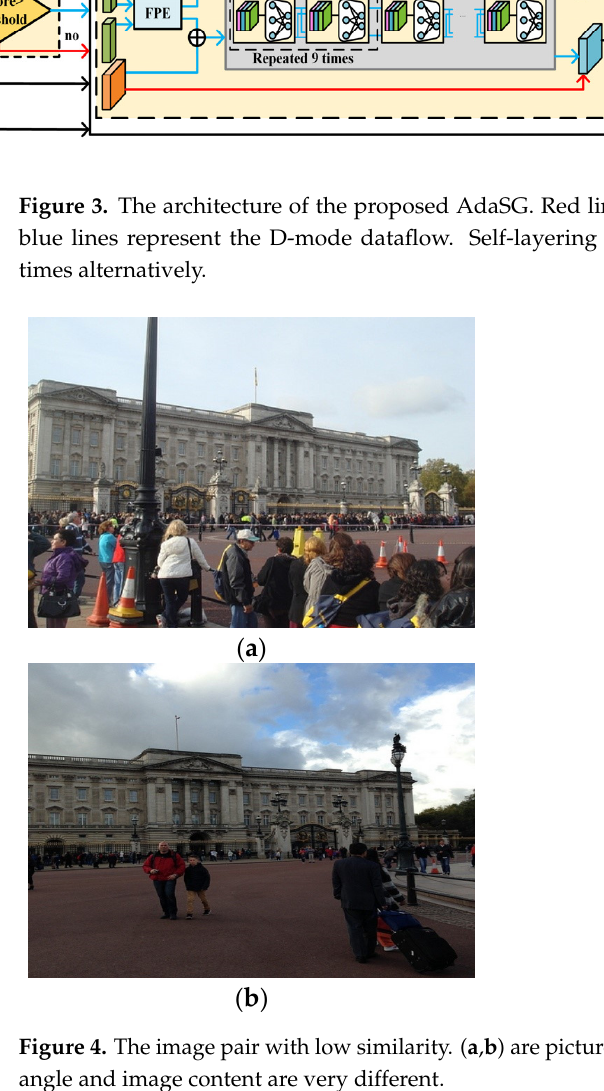
Figure 3. The architecture of the proposed AdaSG. Red lines represent the E-mode dataflow and blue lines represent the D-mode dataflow. Self-layering and cross-layering were repeated nine times alternatively.